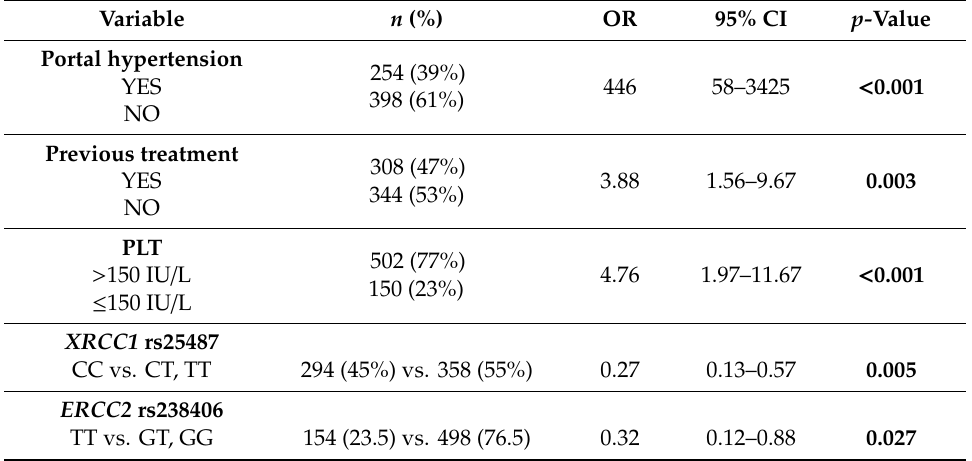
Table 3. Final multiple logistic regression model for liver cirrhosis risk in chronic hepatitis B patients.